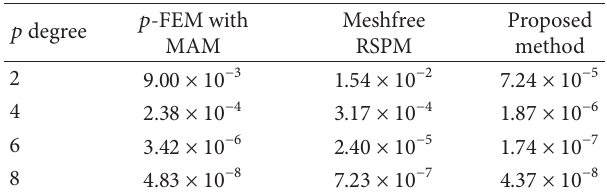
Table 2: Relative errors are compared for different 𝑝 degrees in energy norm.